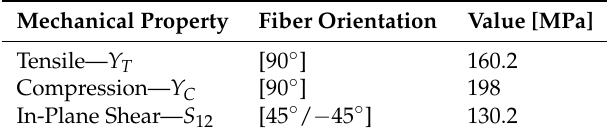
Table 6. Experimental data for IM7-8552 (in situ properties